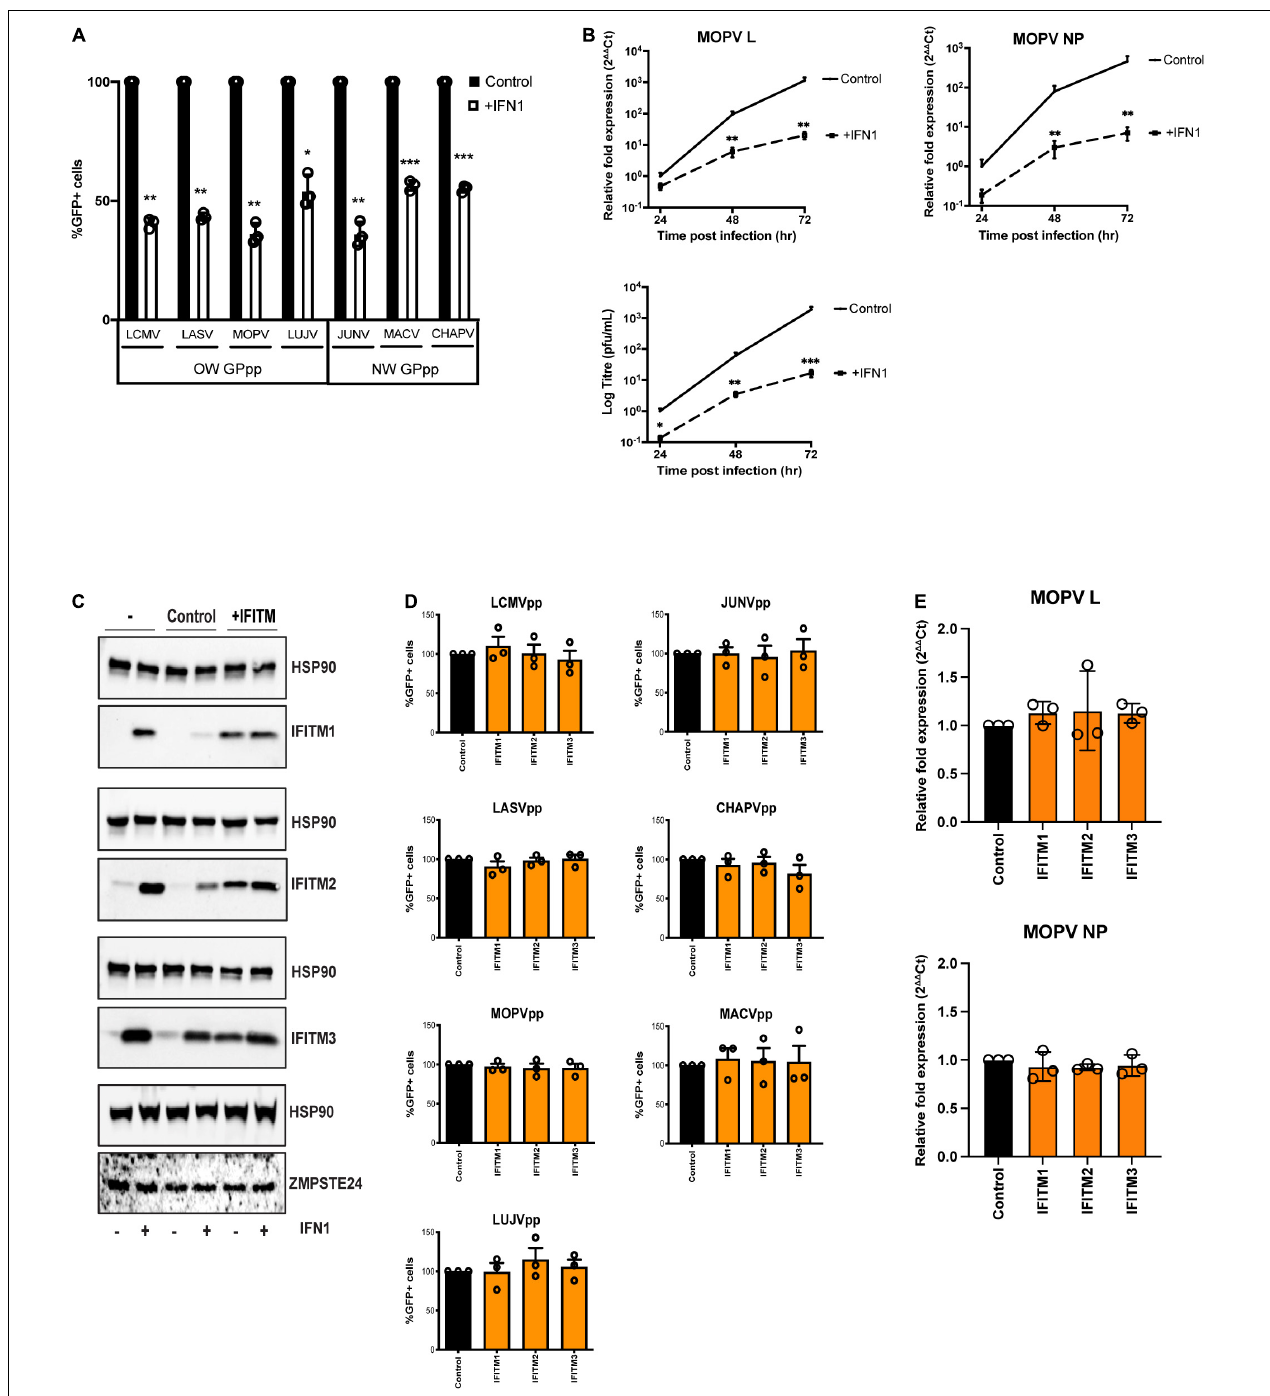
FIGURE 2 | Arenavirus GPpp entry and MOPV replication is inhibited by IFN but is insensitive to IFITM overexpression. (A) A549 cells were infected with GFP-containing arenavirus GPpp in the presence or absence of type 1 interferon (IFN1) and infection was measured by flow cytometry. (B) A549 cells were infected with live MOPV (MOI = 0.01) in the presence or absence of IFN1. MOPV L or NP gene expression was determined by RT-qPCR of extracted RNA and infectious virus in cell supernatants was measured by plaque assay at indicated times post infection. (C) A549 cells were transduced with empty vector control pLHCX, IFITM1, IFITM2 or IFITM3. Expression of IFITMs and ZMPSTE24 was measured in the presence or absence of 1000 U/mL IFN1 by western blot analysis. HSP90 served as a loading control. A549 cells stably transduced with IFITMs were infected with arenavirus GPpp and% infectivity measured by flow cytometry (D) or were infected with live MOPV (MOI = 0.01) for 72 h and MOPV L or NP gene expression was measured by RT-qPCR of extracted RNA (E) . Data are shown as mean ± SE (standard error) of n = 3 independent experiments. Significance is indicated as p -values *** p < 0.0001, ** p < 0.001, * p < 0.05.